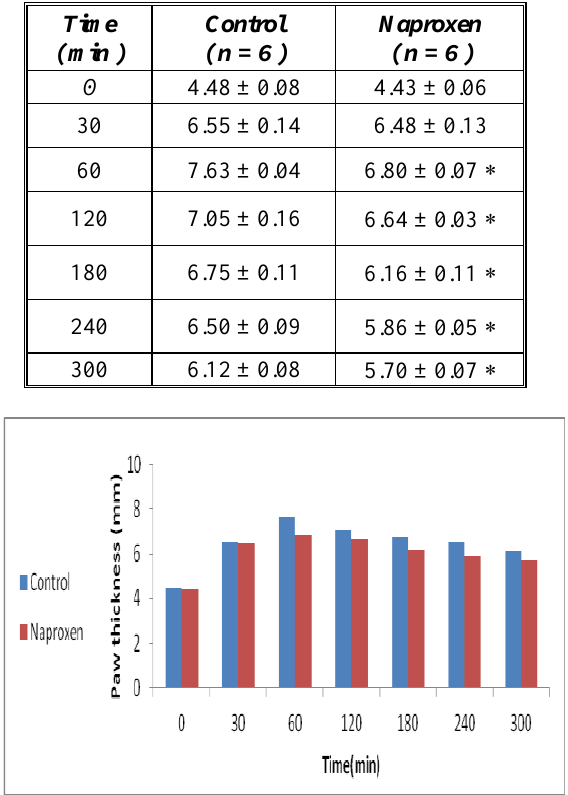
Figure 2. Effect of naproxen (reference), and propylene glycol (control) on egg-white